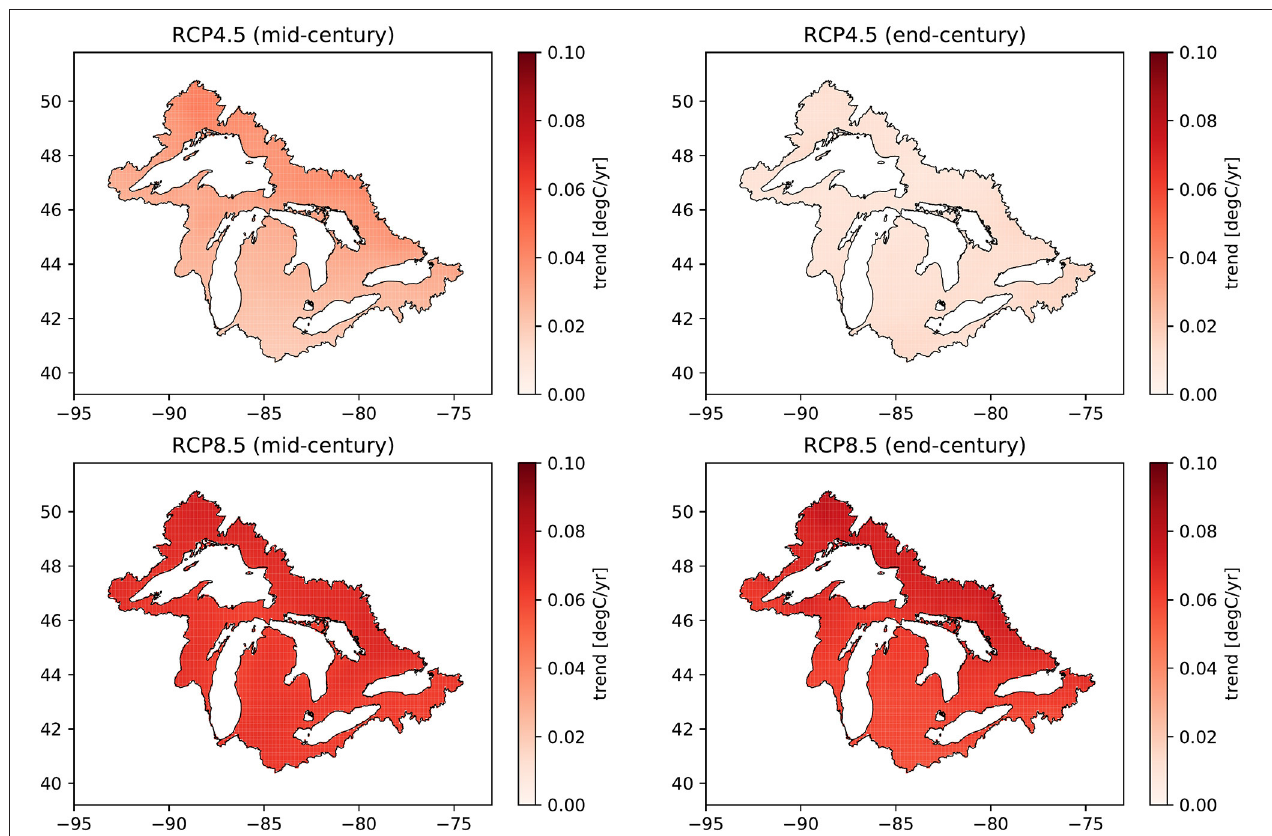
FIGURE 7 | Trend in annual mean temperature of GL basin for RCP4.5 and RCP8.5 scenarios in both mid- and end-century